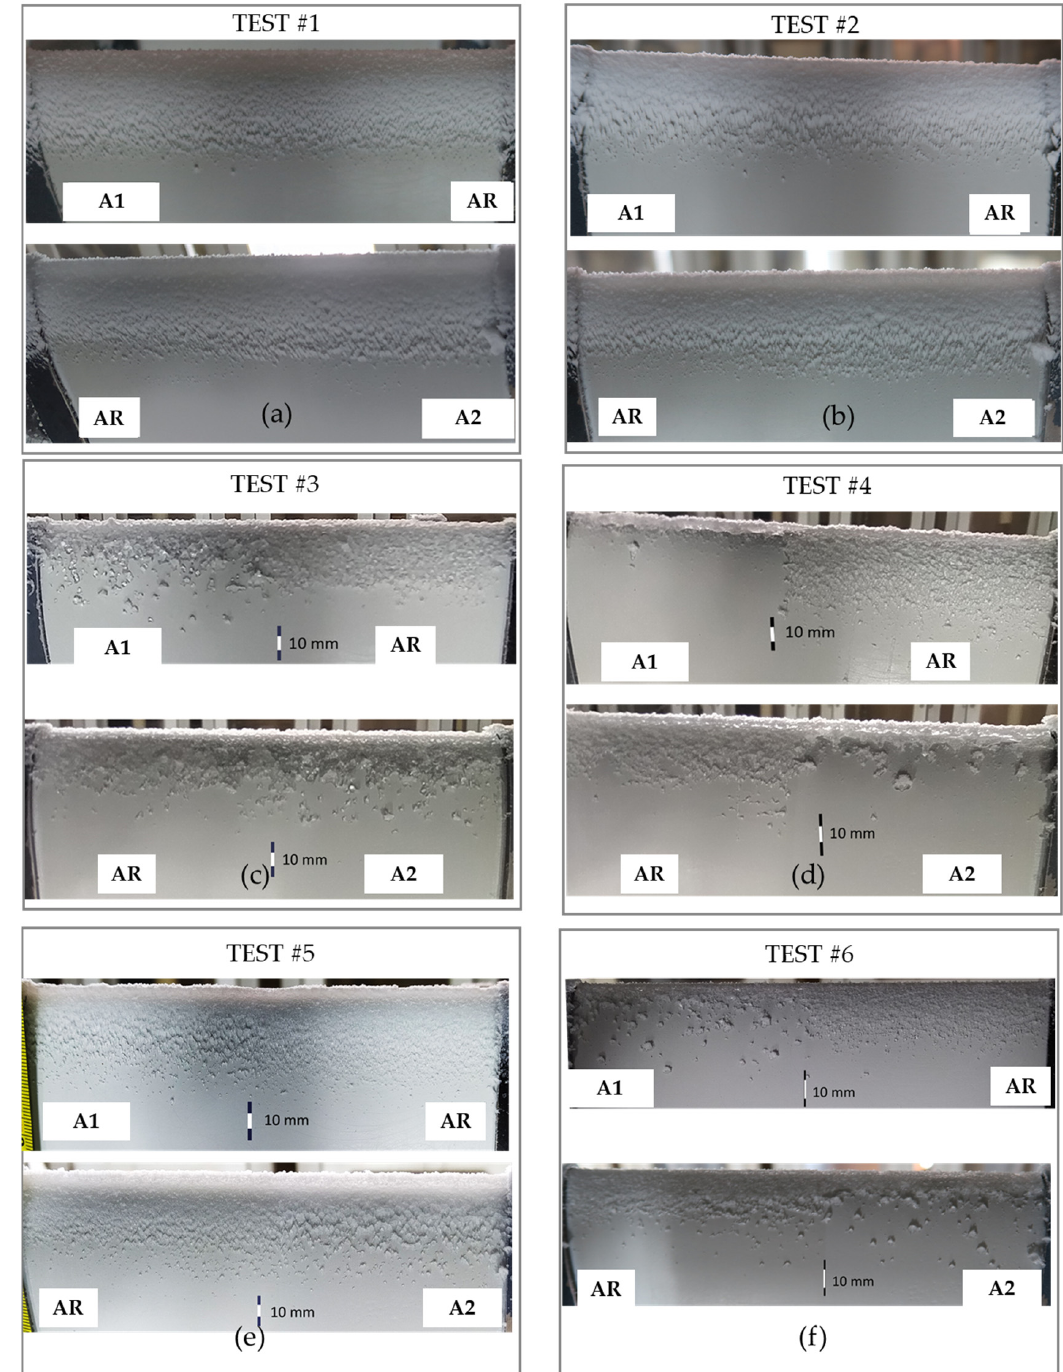
Figure 12. Pictures of ice accreted on A1, A2, and AR samples during the IWT test 1 ( a ), test 2 ( b ), test 3 ( c ), test 4 ( d ), test 5 ( e ), test 6 ( f ).